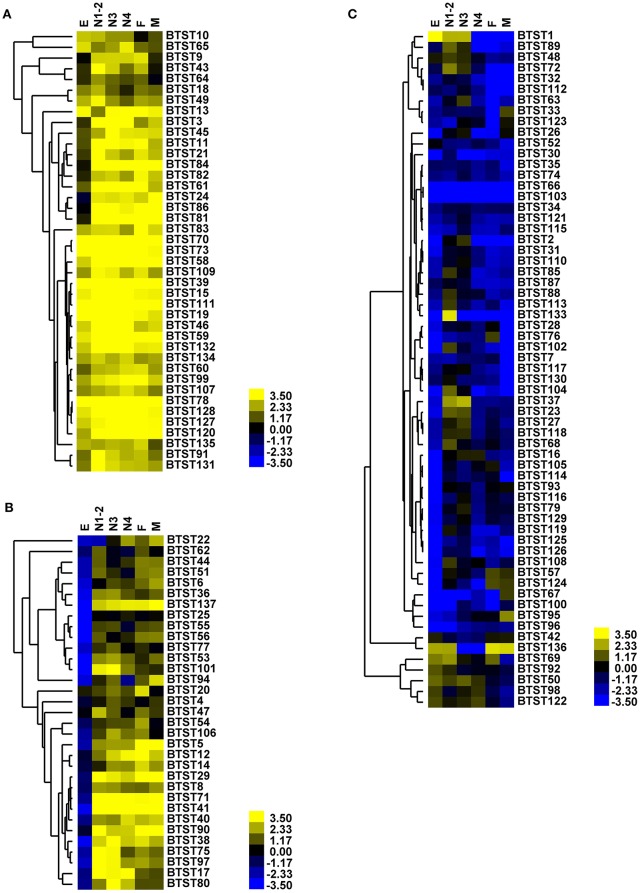
Gene expression of BTSTs across different developmental stages. The log2(FPKM) values are presented as a heatmap. Bright yellow indicates higher expression values, dark blue indicates lower expression values, and gray indicates missing values. E, eggs; N1-2, 1st and 2nd instar nymphs; N3, 3rd instar nymphs; N4, 4th instar nymphs; M, males; F, females. (A) Group 1; (B) Group 2; (C) Group 3.